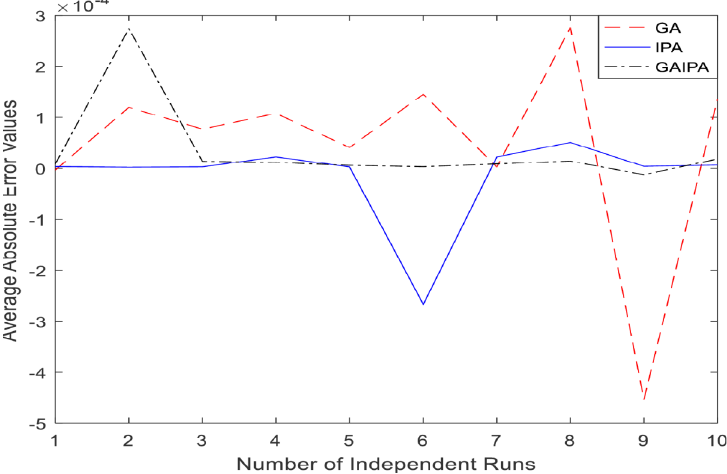
Fig 3. Graphical representation of average absolute errors for Example #02 when δ = 0.5 using Log Sigmoid.